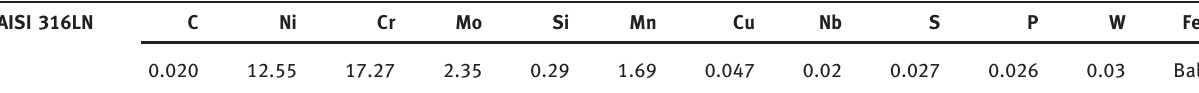
Table 1: Chemical composition (wt %) of substrate material. AISI  LN C